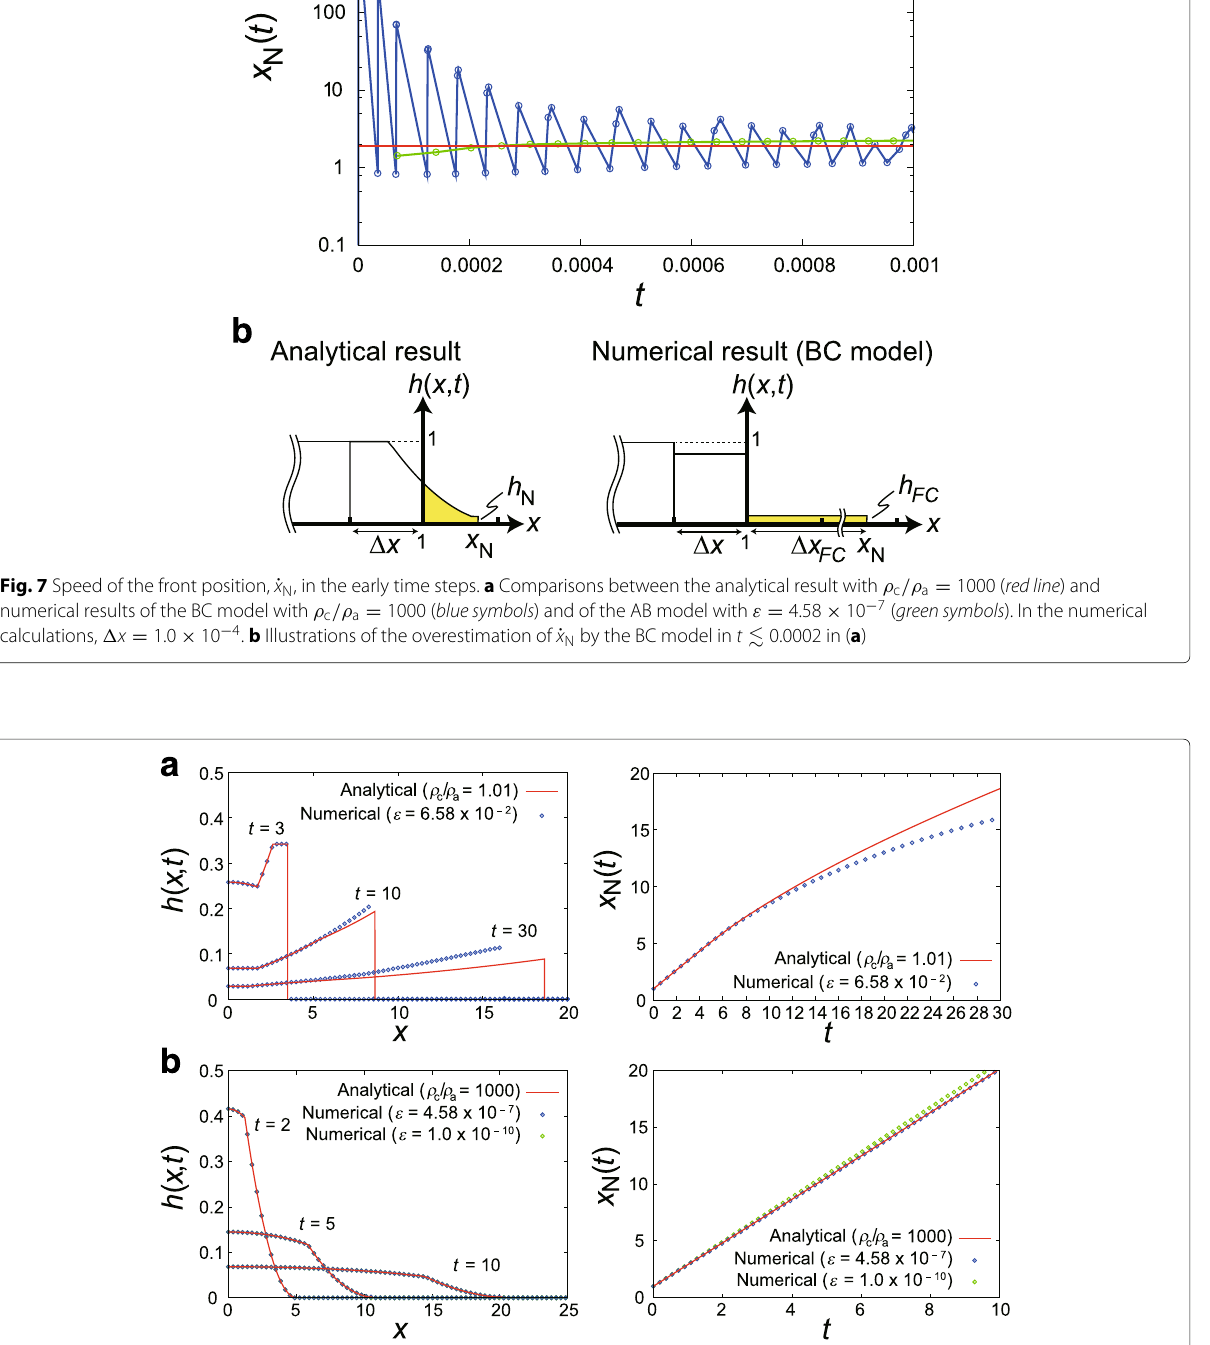
Fig. 8 Analytical results ( redcurves ) and numerical results of the AB model ( symbols ) for h ( x , t ) and x N ( t ) . a ρ c /ρ a = 1.01. b ρ c /ρ a = 1000. In the numerical results, bluesymbols represent the numerical results given ε basedon the analytical solution during the slumping stage( a ε = 6.58 × 10 − 2 ; b ε = 4.58 × 10 − 7 ). Greensymbols represent the numerical results given ε = 1.0 × 10 −